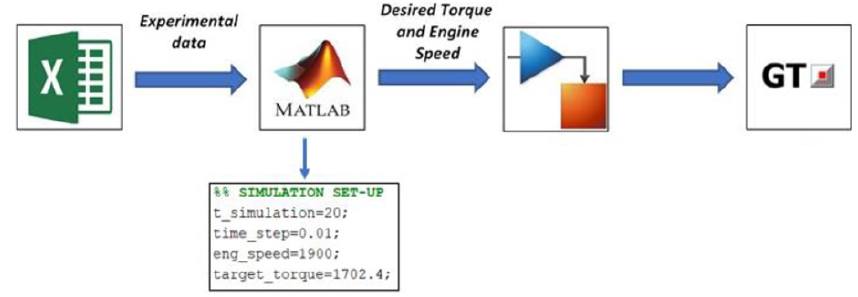
Figure 3. Illustrative scheme of GT-SUITE/Simulink coupling mechanism.